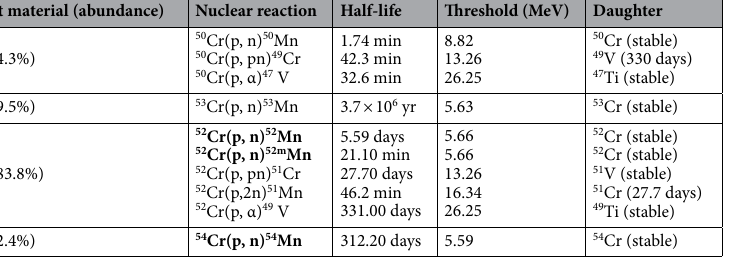
Table 2. Potential products and impurities through the reactions nat Cr(p,x)X. The bolded reactions are the most common products observed. This work used a maximum irradiation energy of 12.9 MeV while the cross section from El Sayed et al., 2019 at that energy is 249.8 mb. (Modified from El Sayed et al. 2019) 10,12 .